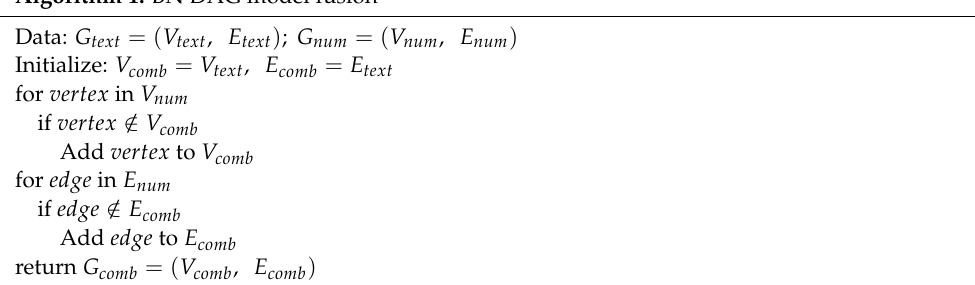
Algorithm 1. BN DAG model